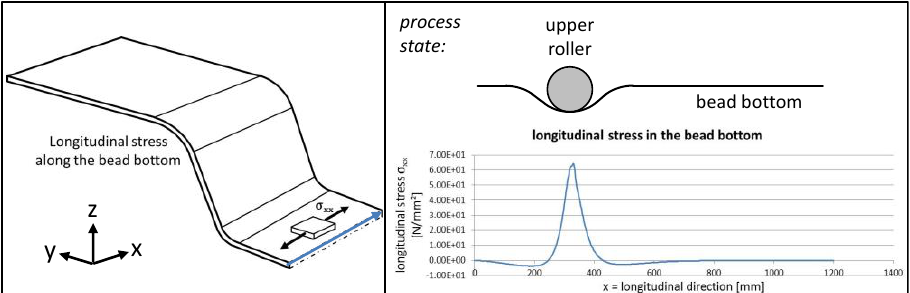
Figure 13. Lateral stresses along a transverse section of the profile during the process.